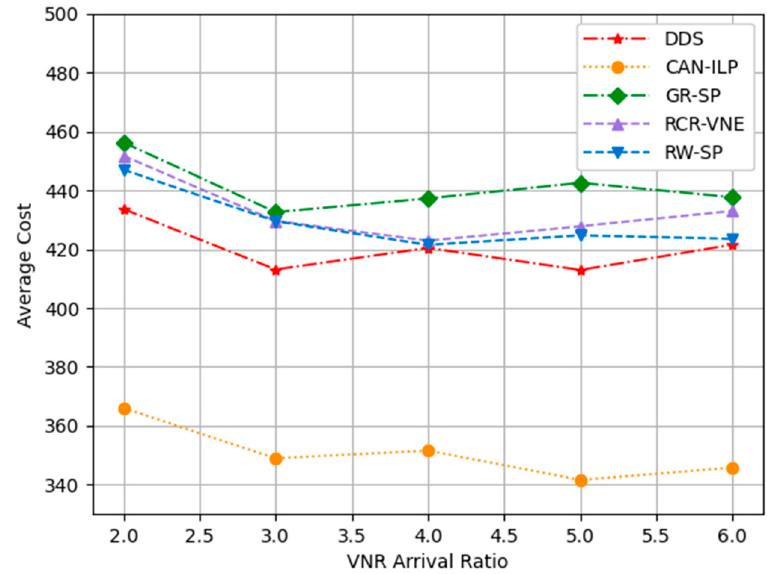
Figure 4. Average cost under various VNR arrival ratios.